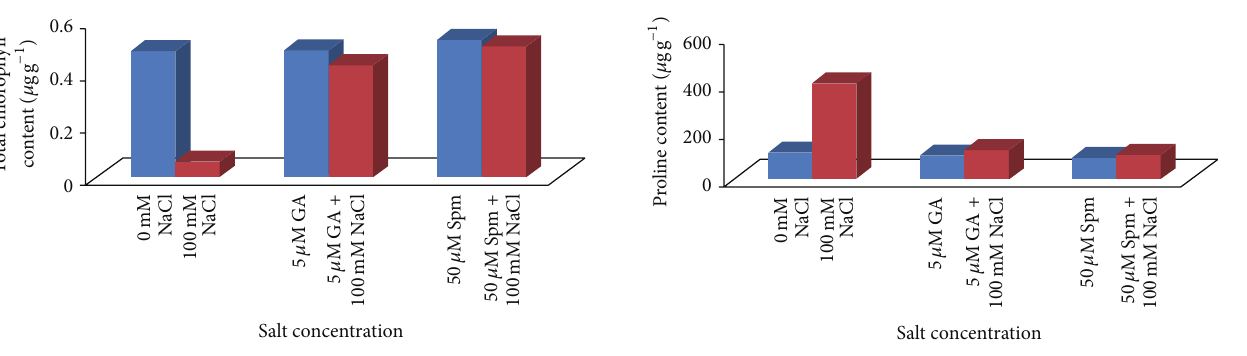
Figure 6: Effect of NaCl on the total proline content of 10-day-old mungbean seedling and its possible amelioration with 5 𝜇 M GA 3 and 50 𝜇 M